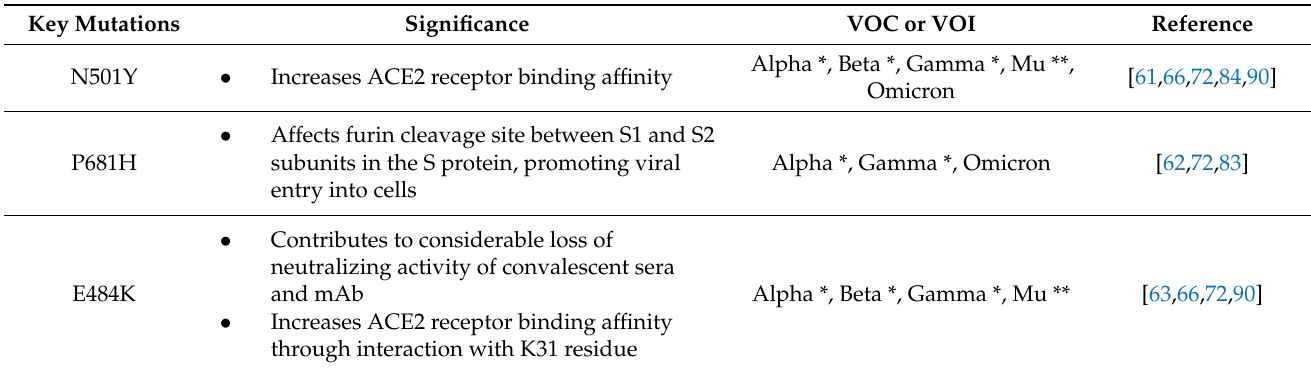
Table 1. Significance of key mutations found in SARS-CoV-2 VOIs and